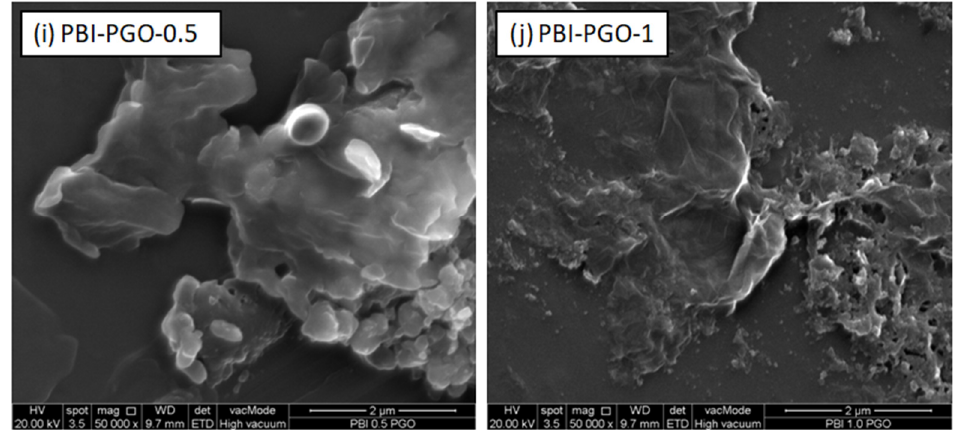
Figure 4. ( a – j ) Polybenzimidazole (PBI) and PBI composites with GO, PGO, and SGO at different loading levels.